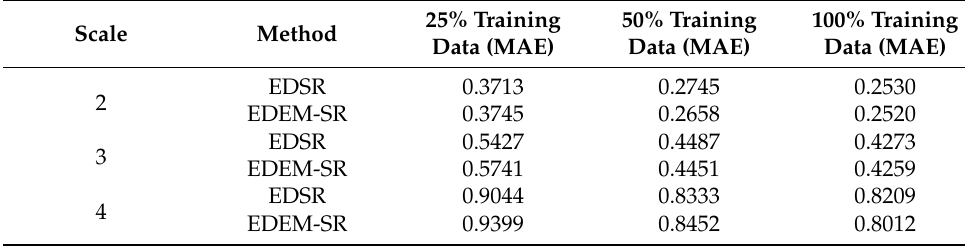
Table 4. Performance of different models trained with different amounts of training